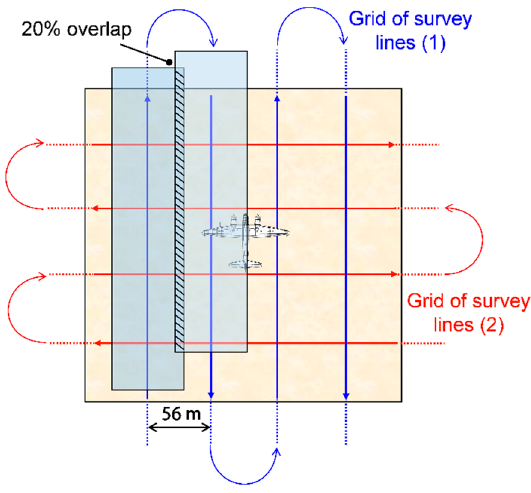
Figure 4. Grids of bathymetric survey lines planned in the wreck site.